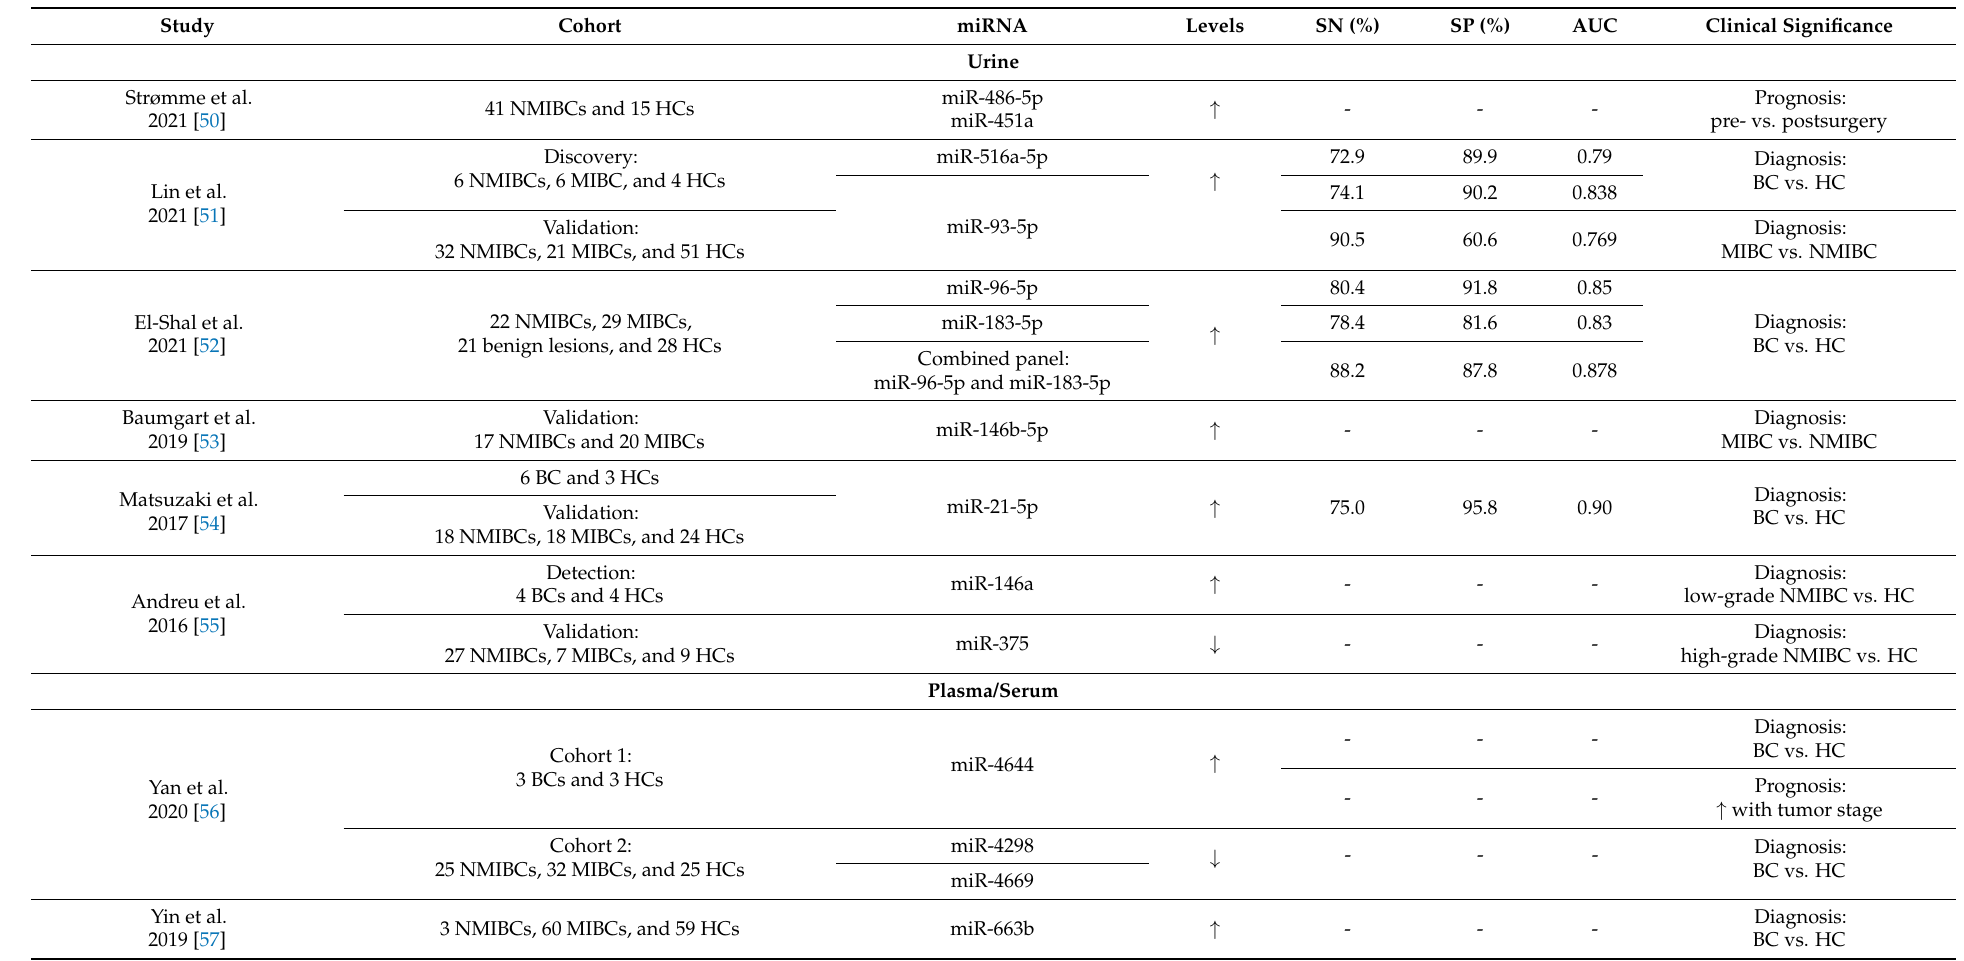
Table 1. miRNAs with potential in the management of bladder cancer